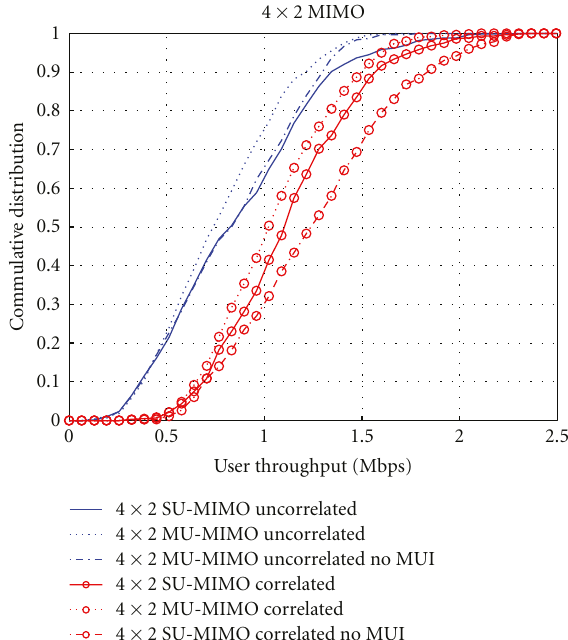
Figure 7: Distribution of the user throughput and the average cell throughput for 4 × 2 MIMO